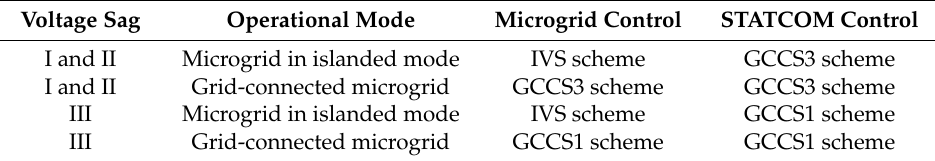
Table 7. Selected control policies for the microgrid with STATCOM under different voltage